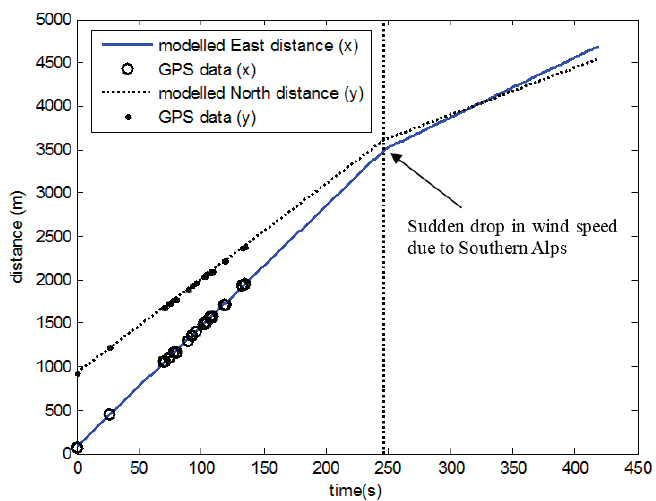
Figure 16. Modelled versus measured displacements in East ( x ) and North ( y )